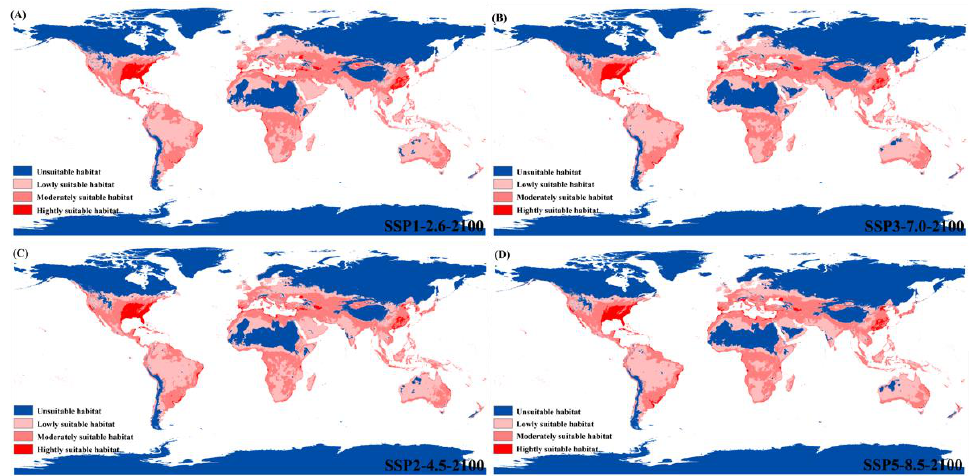
Figure 6. Habitat distribution of P. flavescens under four carbon emission levels in 2100. ( A ) SSP1- 2.6: the low-end level; ( B ) SSP2-4.5: the low-moderate level; ( C ) SSP3-7.0: the medium-high level; ( D ) SSP5-8.5: the high SSP5-8.5 level.